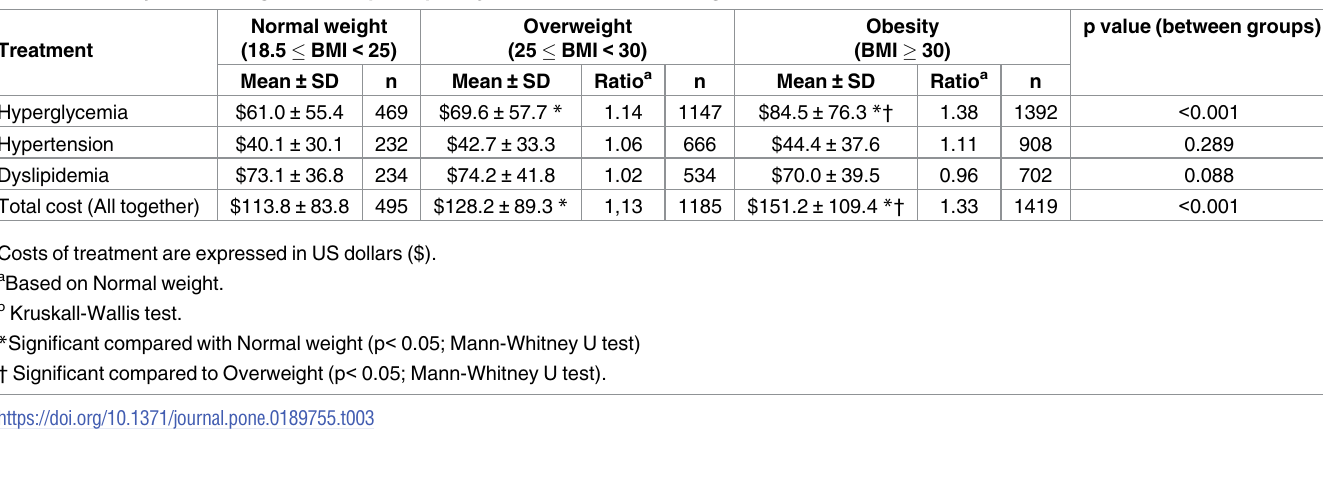
Only diet and Phys. activity